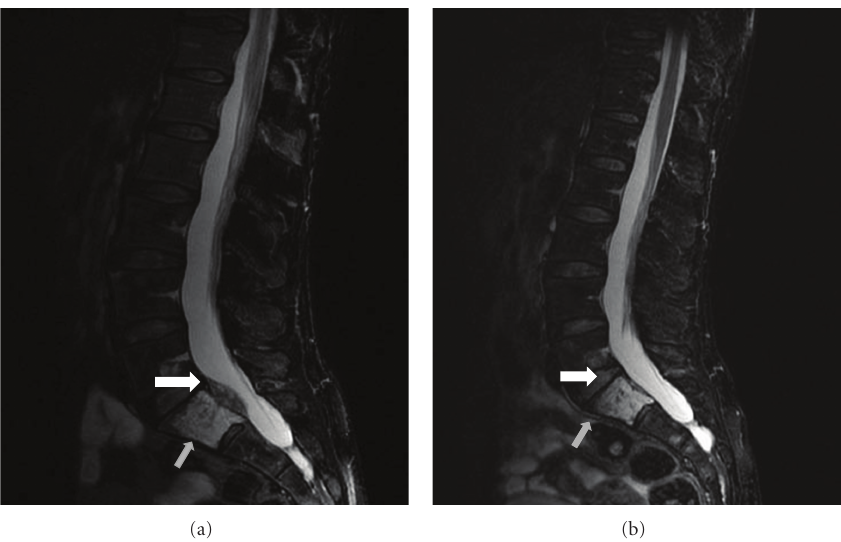
Figure 1: Magnetic resonance imaging (T2 sagittal image) performed at the patient’s initial clinical presentation shows S1 metastasis (gray arrow) and cord thecal sac compression (white arrow) (a). Magnetic resonance imaging (T2 sagittal image) performed 3 years after the patient’s second RAI treatment shows complete resolution of the tumor